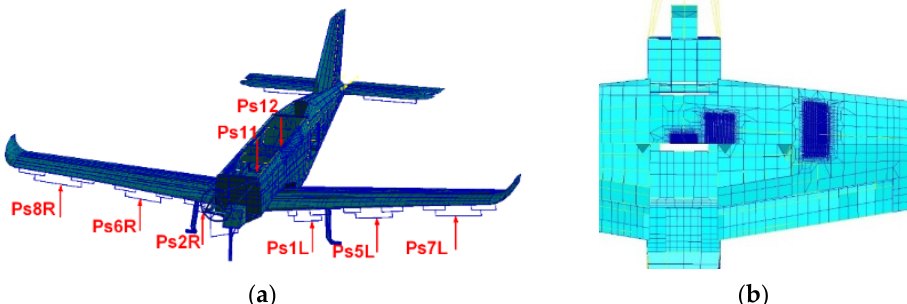
Figure 4. Global FEM model of the aircraft structure. ( a ) Load introduction according to the actual FSFT actuators layout; ( b ) local mesh densification (middle mesh) in order to obtain detailed strain fields for submodels (bottom view). Table 1. Values of forces used for strain field definition in the global FEM model.